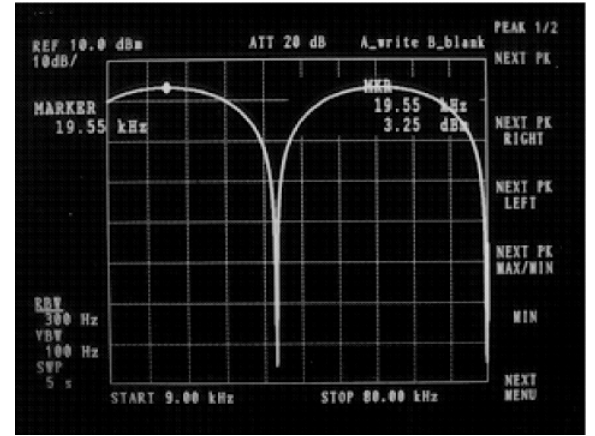
FIG. 7. Frequency response of the two-tap filter with the tap position of (cid:1) 1, 401 (cid:2)